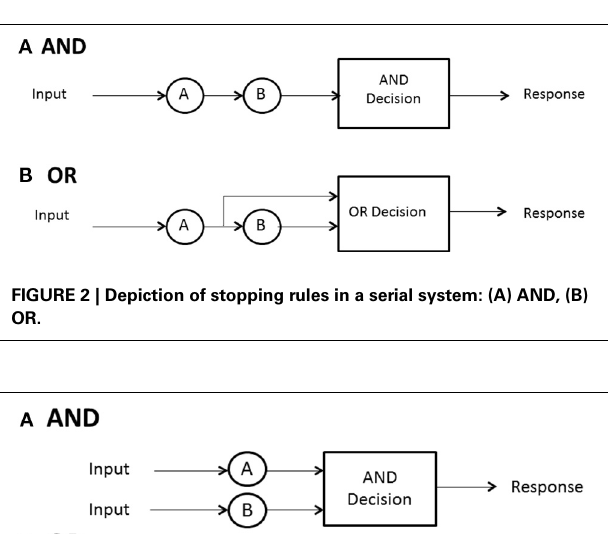
is found, and (c) exhaustive or AND processing, where all